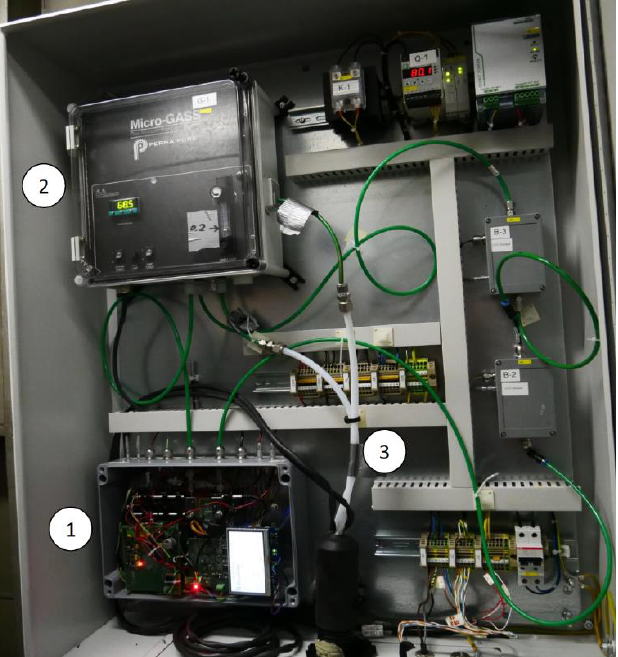
Figure 9. The internal components of the switch cabinet that were installed on the container ship PRIAMOS: (1) The developed photoacoustic SO 2 sensor system. (2) The MicroGASS gas sampling system (Perma Pure, LCC) dries and cools the gas sample down. (3) Gas inlet and outlet tubes of the measured gas from and to the switch cabinet, which pass through the temperature-controlled pipe.